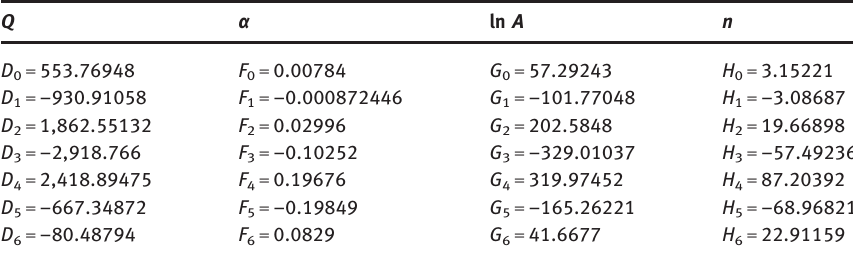
Table 2: Results of the polynomial fit of Q , α , ln A , and n for the α + β phase.